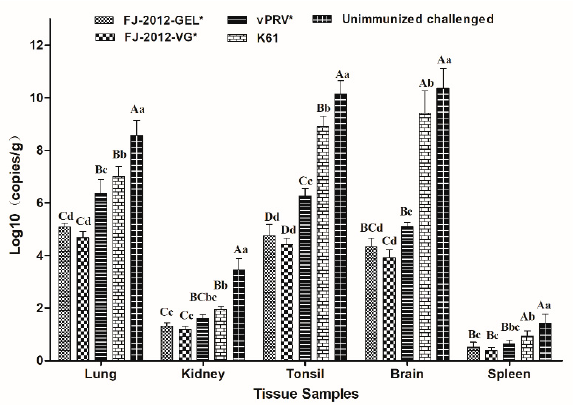
Figure 5. Viral load in different tissue samples from piglets after challenge. Viral genome numbers are presented as mean ± SD as measured by one-way repeated measurement analysis of variance (ANOVA) and least significant difference (LSD); the uppercase letters on the group bar indicate that the difference was extremely significant ( p < 0.01); lowercase letters indicate a significant difference ( p < 0.05). The “*” mark in the group top right indicates an inactivated vaccine.